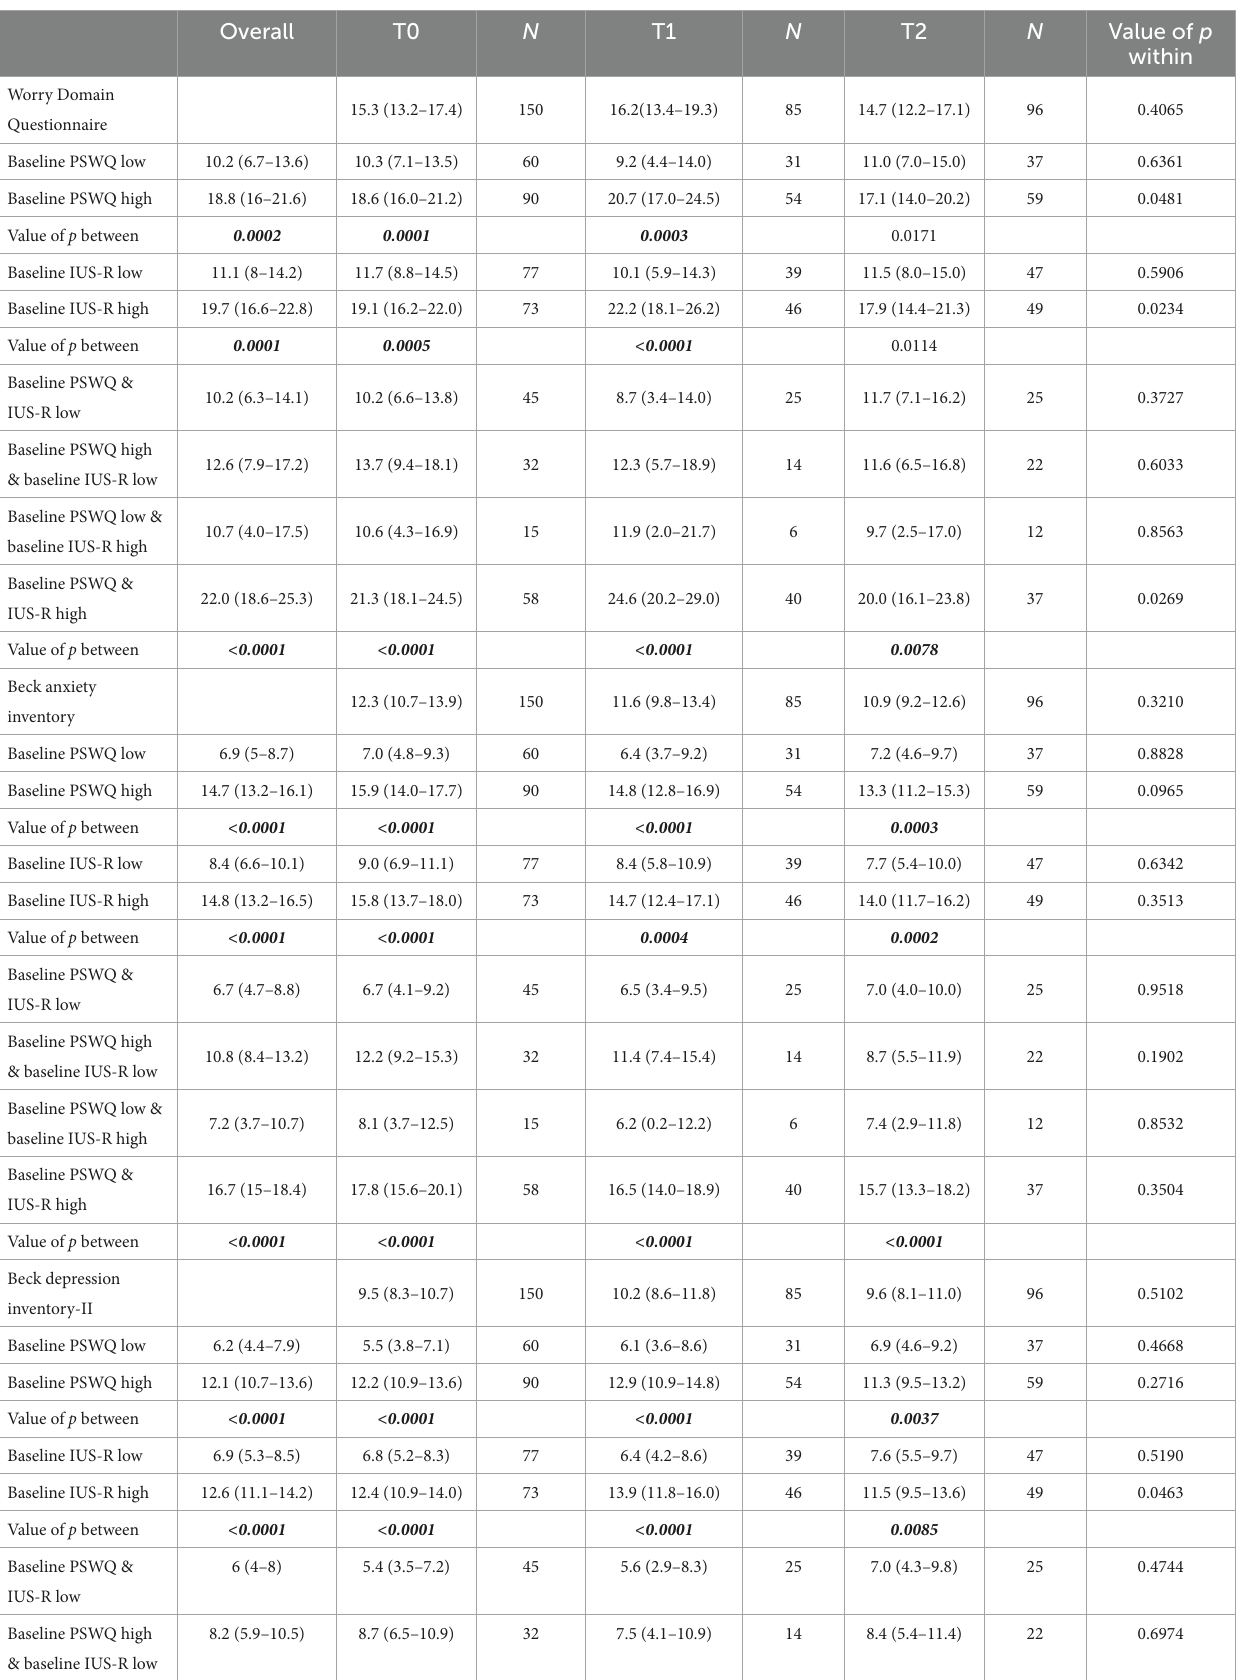
TABLE 2 Mean changes over time and across clinical characteristics of the worry content, anxiety, depression, and post-traumatic stress symptom scales (T0: N = 150; T1: N = 85; T2: N = 96). Overall